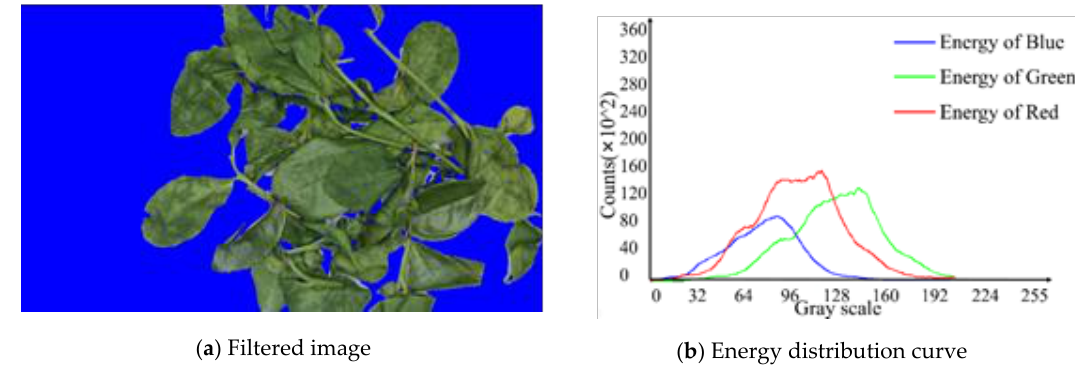
Figure 5. Filtered image data dimension reduction.